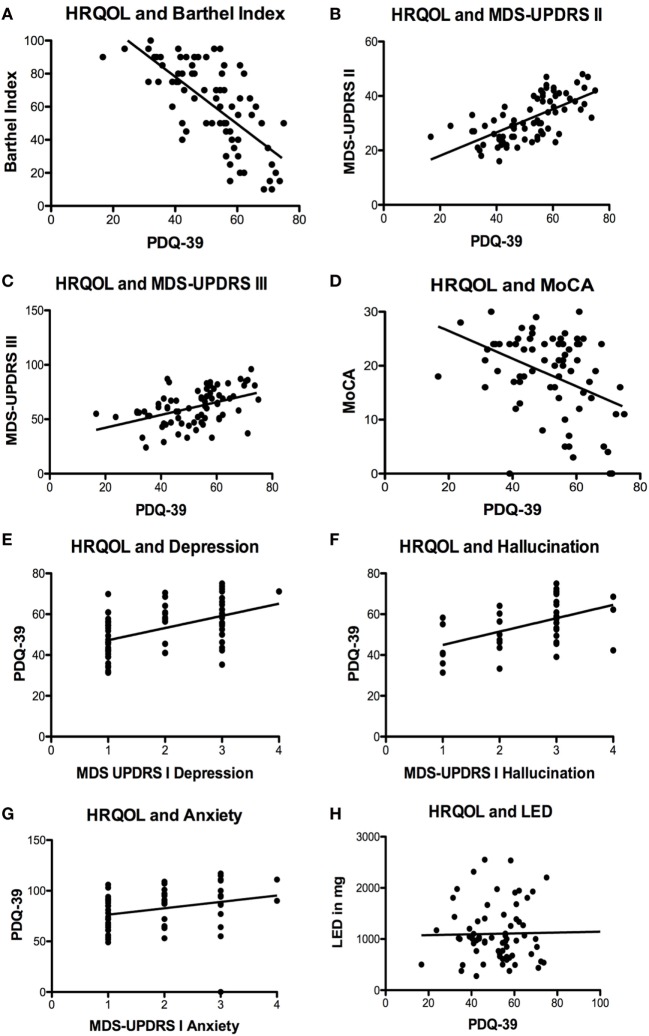
Significant correlations of health-related quality of life (HRQOL) with different scales und symptoms. (A) Negative correlation of HRQOL and Barthel Index (p < 0.0001; r = −0.6946; r2 = 0.4825). (B) Correlation of HRQOL with Movement Disorders Unified Parkinson’s Disease Rating Scale (MDS-UPDRS) part II (p < 0.0001; r = 0.6586; r2 = 0.4338) and (C) MDS-UPDRS part III (p < 0.0001; r = 0.4562; r2 = 0.2081). (D) Negative correlation of HRQOL and Montreal Cognitive Assessment test (MoCA) (p = 0.0002; r = −0.4136; r2 = 0.1711). (E) Correlations of HRQOL with MDS-UPDRS part I item “depressed mood” (p < 0.0001; r = 0.4862; r2 = 0.2364) and (F) MDS-UPDRS part I item hallucinations and psychosis (p = 0.0018; r = 0.4841; r2 = 0.2344) and (G) MDS-UPDRS item “anxious mood” (p = 0.0431; r = 0.2689; r2 = 0.0723). (H) Non-significant correlation of HRQOL and levodopa equivalence dosage (LED) (p = 0.5035; r = 0.0825; r2 = 0.0068).